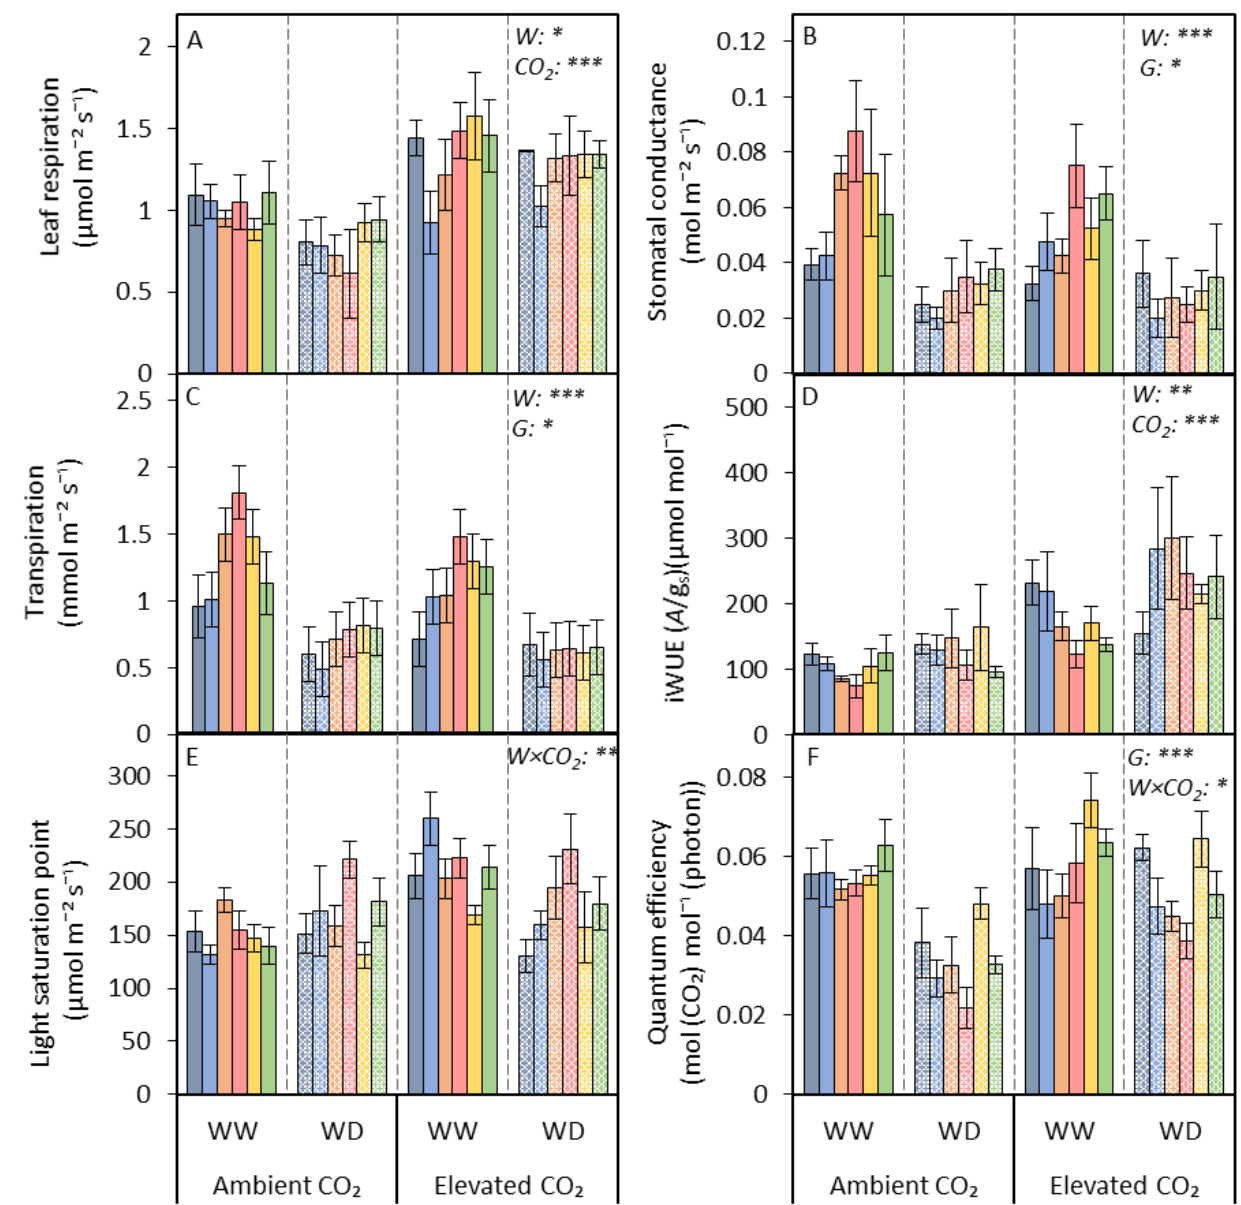
Figure 3. Photosynthetic responses of six different genotypes of cacao to elevated CO 2 and water deficit ( A – F ). Error bars are standard error of the mean. Grey bars: CL 19/10; blue bars: ICS 1, orange bars: IMC 47; pink bars: POUND 7/B; yellow bars: SCA 6; green bars: SPEC 54/1. Where statistical differences were identified between the main factors these are noted on the top right of each plot. The asterisks indicate the factors and any interactions which had a significant effect on each response variable (W: water treatment; CO 2 : CO 2 treatment; G: genotype; * p < 0.05; ** p < 0.01; *** p <